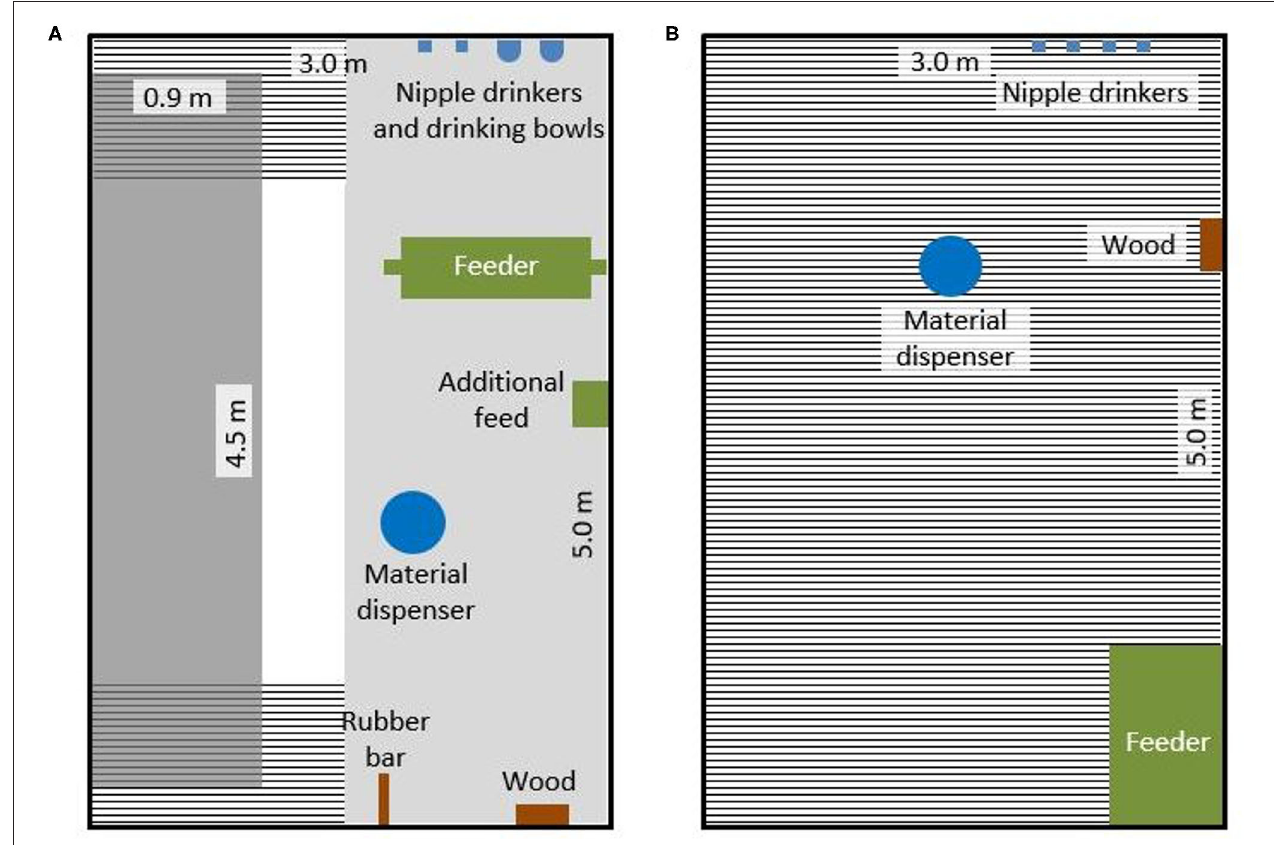
FIGURE 1 | Schematic drawing of a (A) rearing and (B) fattening pen with partly slatted concrete floor with 7% perforation (white), slatted concrete floor with 17% perforation (striped), slatted plastic floor with 38.5% perforation (light gray) and heated covering (dark